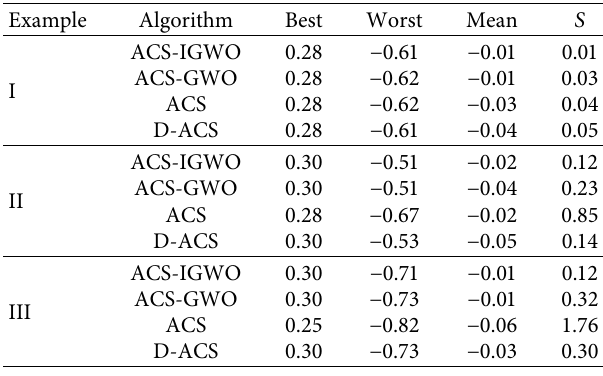
Table 14: Comparison of algorithms of different node